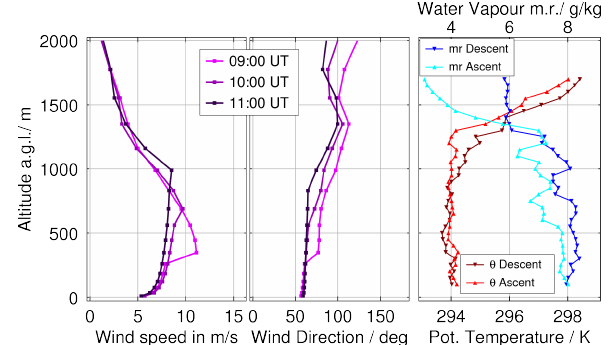
Figure 15. Example vertical profiles of wind speed (left) and wind direction (middle) from the COSMO-DE model on 4 June 2011 at three time steps (09:00, 10:00 and 11:00UTC) for the location 7.67 ◦ E, 52.28 ◦ N, close to the Ibbenbüren power station, as well as potential temperature (cid:50) , and water vapour mixing ratio m.r., during a dive south of the power plant (right).